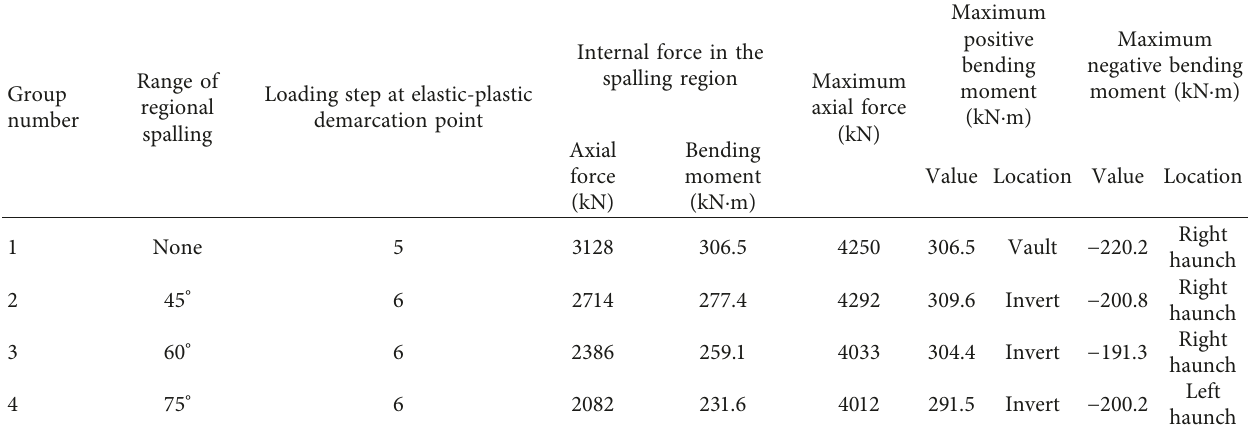
Figure 14: Load-bending moment curves at key points of lining. Variation curve of bending moment for (a) group 1, (b) group 2, (c) group 3, and (d) group 4. Table 9: Statistics of the internal force features in elastic-plastic demarcation